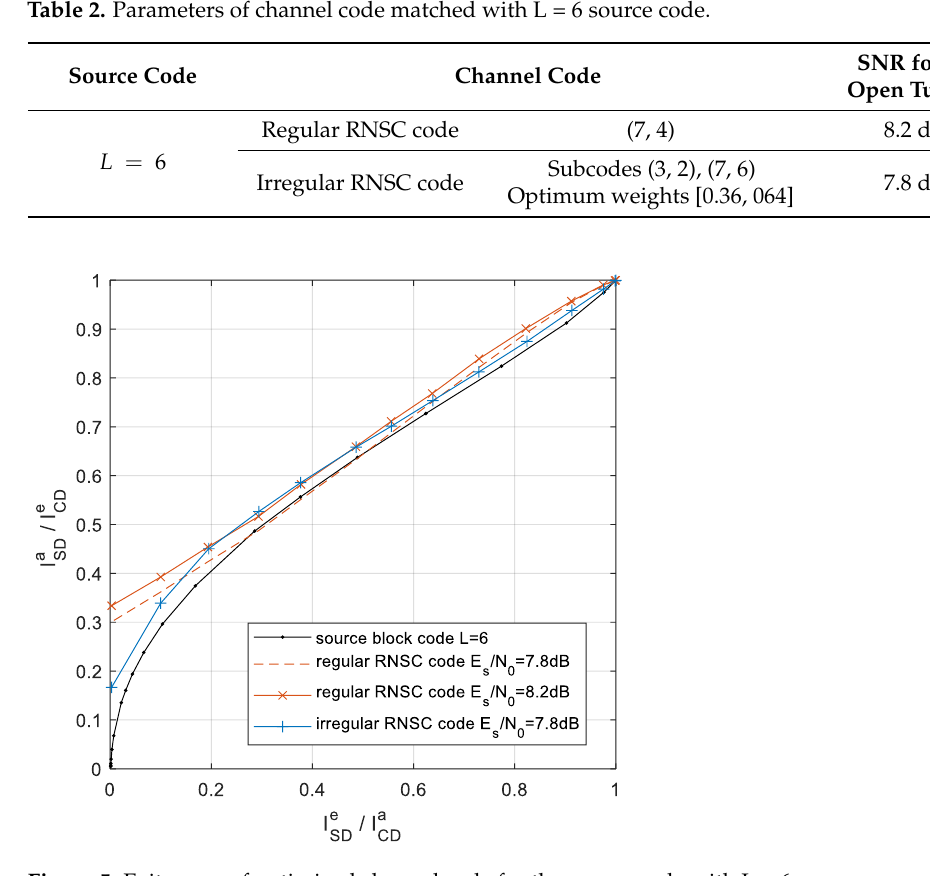
Table 2. Parameters of channel code matched with L = 6 source code.